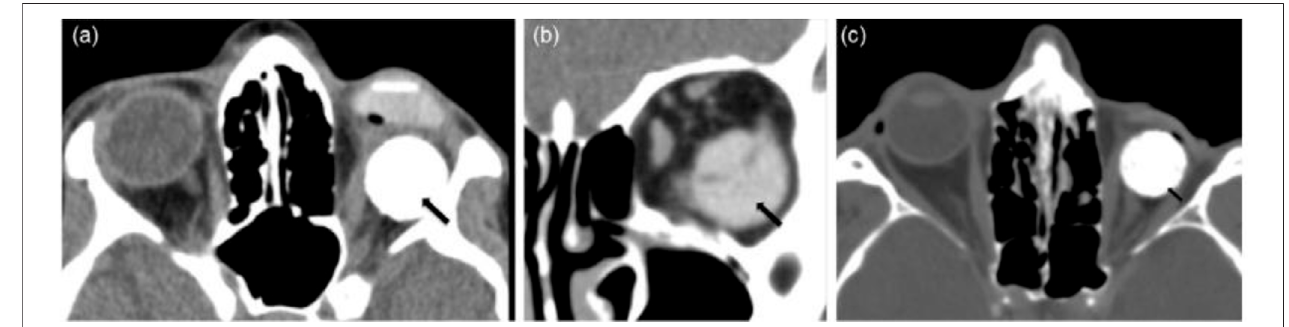
FIGURE 3 | The images are examples of orbital implant complications: (A) axial and (B) coronal CT images displaying an orbital prosthetic implant that has relocated inferotemporal (black arrows) whereas the underlying ocular prosthesis is properly sited; (C) axial CT image illustrating the “ postenucleation socket syndrome ”— decreased orbital volume on the left with the posteriorly placed hydroxyapatite spherical implant; and (D) (black arrow). Reproduced with permission from (Adams et al., 2014).